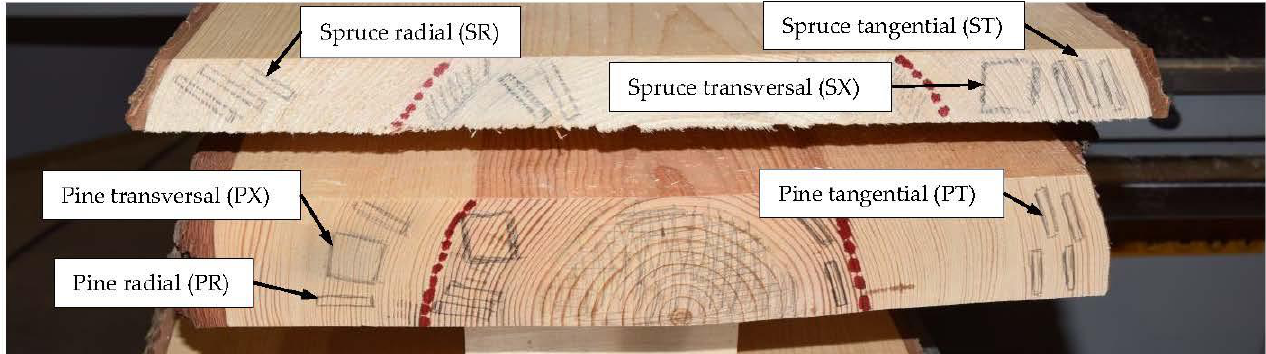
Figure 2. Boards used for the preparation of wood specimens. Spruce board is located on the top, pine board on the bottom. Red dashed lines separate heartwood and sapwood. The dimensions of the specimen were 20 mm × 20 mm × 3 mm. The wood specimens (P—pine, S—spruce) were cut with respect to main anatomical directions (Figure 2) to study mold growth on the tangential (T), radial (R), and transversal (X) surfaces. The